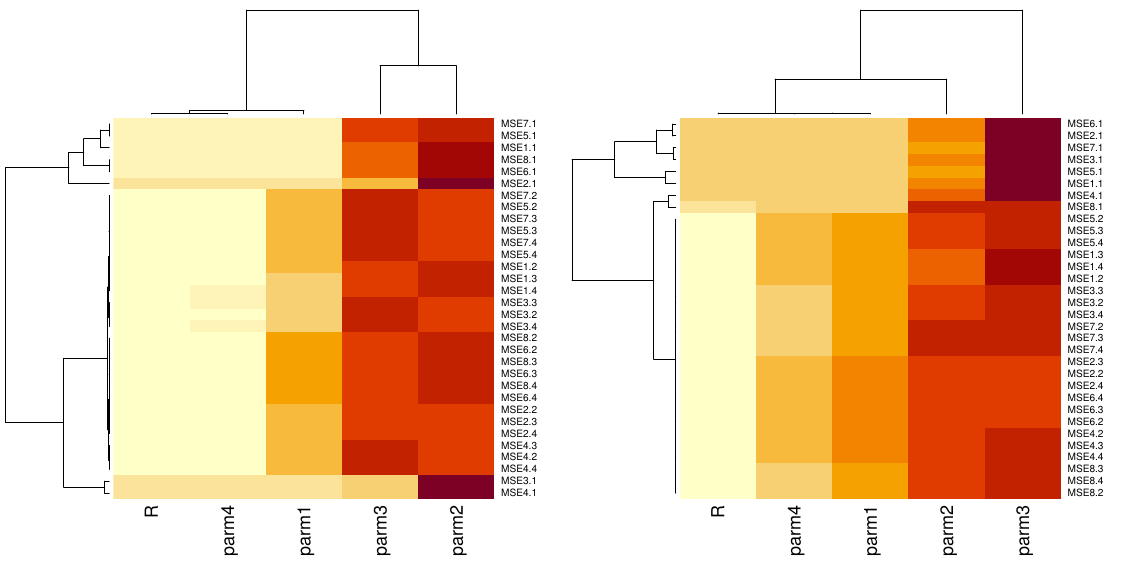
Figure 2. Heatmaps of MSE for parameters and R based on different estimation methods: Case I and